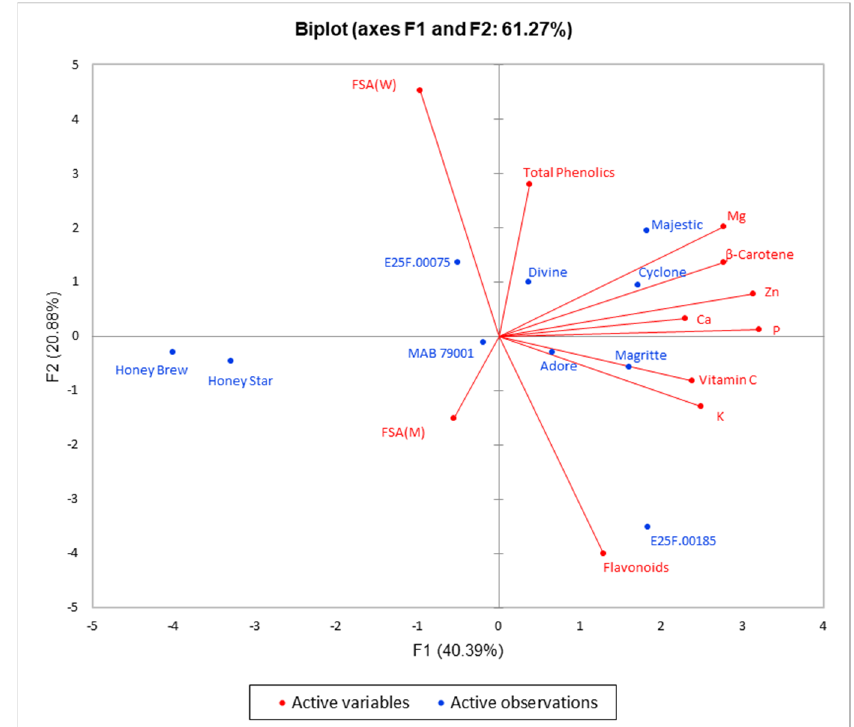
Figure 5. Principal component biplot of fruit nutritional and phytochemical qualities for the evaluated honeydew and cantaloupe melon cultivars at harvest. FSA (W) = free radical scavenging activity of water extract; FSA (M) = free radical scavenging activity of 50% methanol extract.